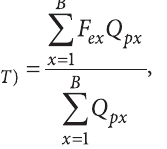
Table 6. Adjustment factors to exposure and the corresponding risk levels